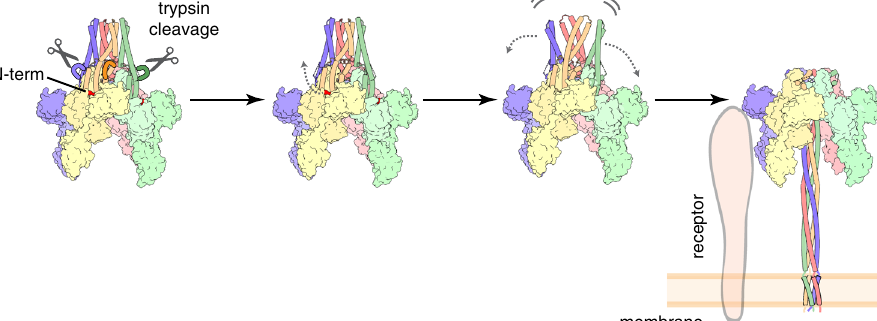
Fig. 5 Activation mechanism of Vip3Aa. Protease digestion is required for Vip3 activation as it facilitates, possibly in conjunction with other factors, the remodeling of the spring-loaded helices that form the protoxin apex. This set of long-range conformational changes releases the N-terminus segment of the protein and leads to the formation of a four-helix coiled coil, which is suf fi ciently long to reach and permeate the lipid